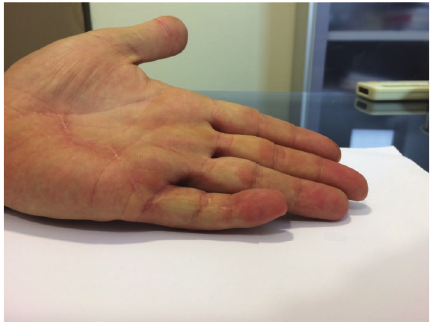
Figure 1: The white arrow indicates the proximal stump of the FDP, and the black arrow the distal dilacerated stump of the FDS.